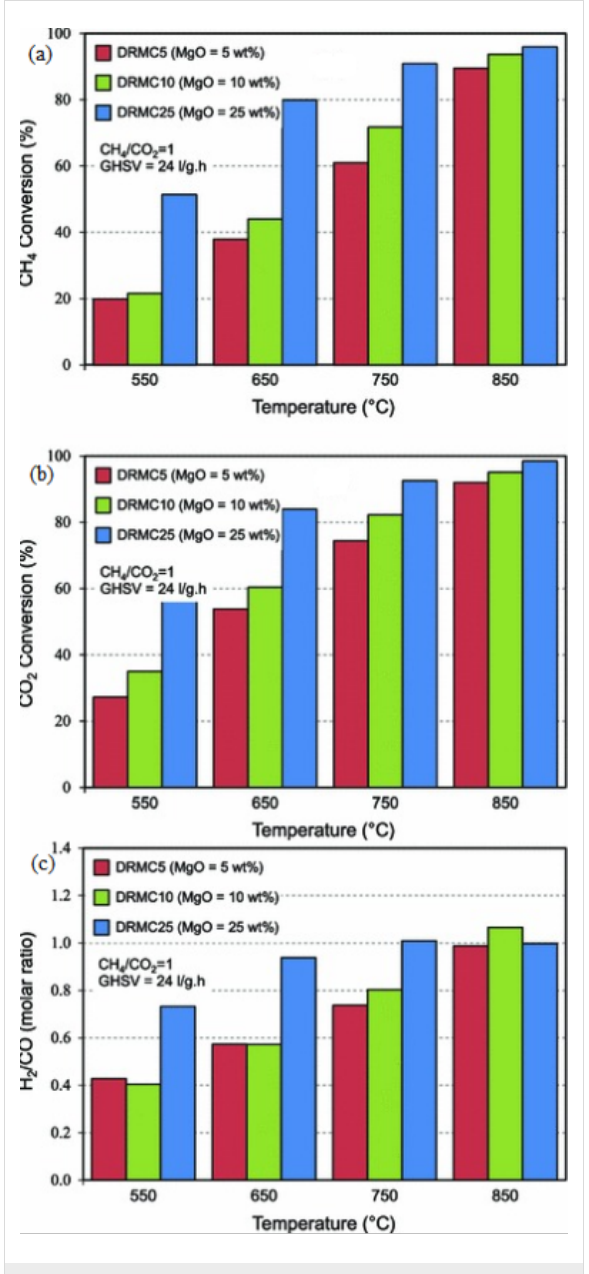
Figure 12: Effect of MgO loading on (a) CH 4 , (b) CO 2 conversion and (c) H 2 /CO molar ratio over various MgO loadings (5, 10, 25 wt %). Reprinted from [38], copyright 2014, Springer